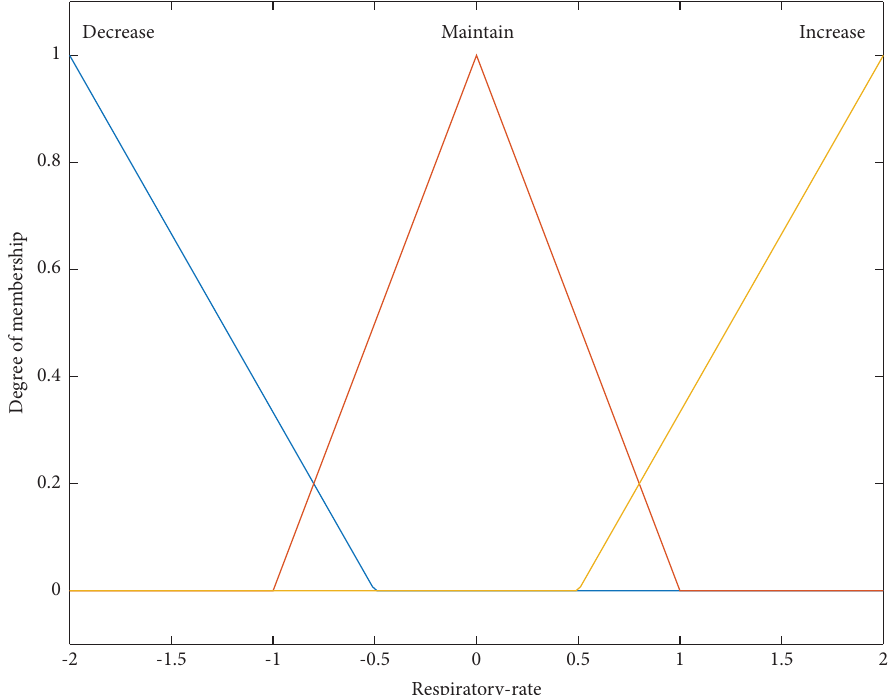
Figure 7: Membership function for change in respiratory rate output.